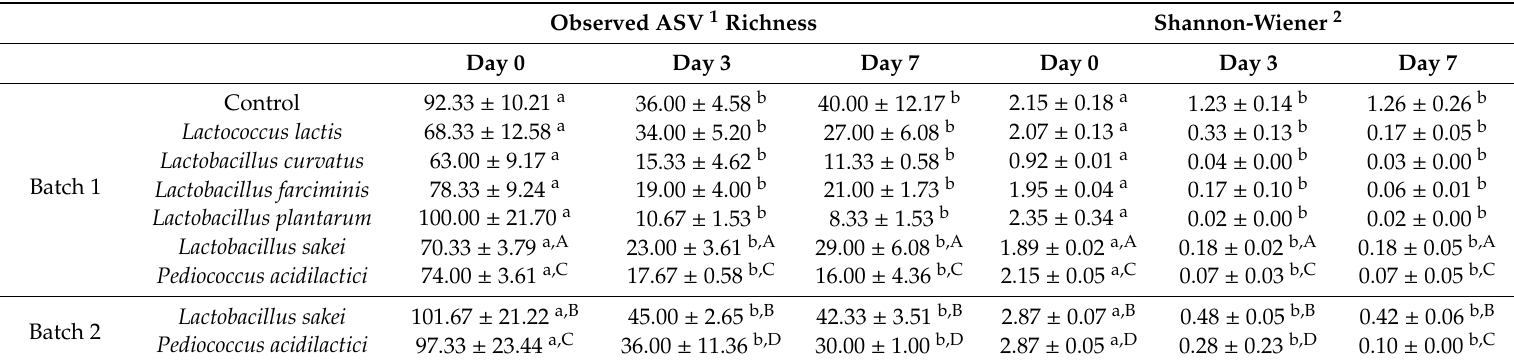
Table 1. Microbial community diversity indices of fermented mealworm paste subjected to metagenetic analysis (without the addition of sodium